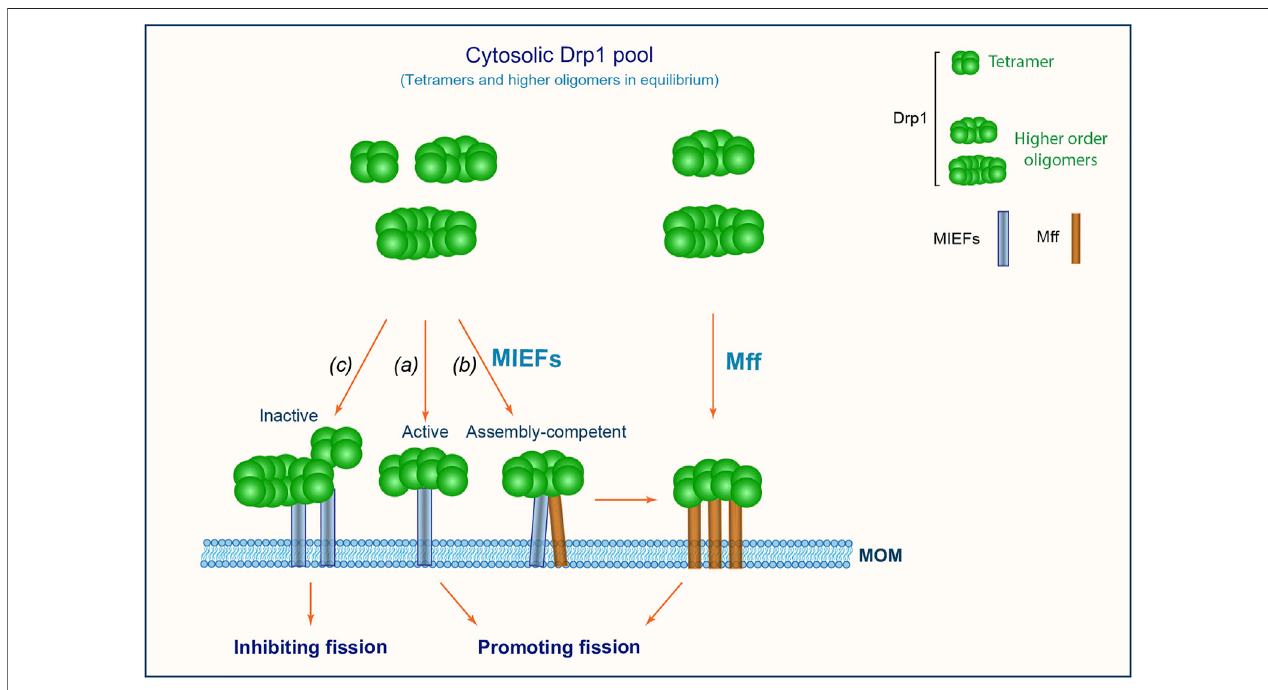
FIGURE 9 | A proposed model for mitochondrial recruitment of Drp1 through MIEFs (MIEF1 and MIEF2) and Mff. Drp1 exists in the cytosol as a reservoir of tetramers and higher order oligomers in active and inactive states. MIEFs can recruit all assembly forms including active and inactive forms of Drp1 to mitochondria. Underphysiologicalconditions, MIEFsbindtoactive formsofDrp1facilitating fi ssion (A) ;MIEFsserveasaplatformtofacilitatetheinteraction betweenMffandDrp1 (B) ; However,highlevelsofMIEFsgiverisetoDrp1aggregatesandsequestertheproteininaninactivestateresultingintheinhibitionof fi ssion (C) .Incontrast,Mffalone preferentially recruits GTPase-active and fi ssion-competent forms of Drp1 to mitochondria promoting fi ssion.